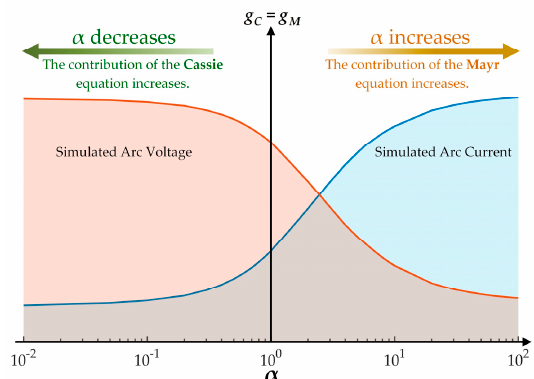
Figure 7. The influence of α on the simulated arc current and arc voltage when P 0 and U C are constant.